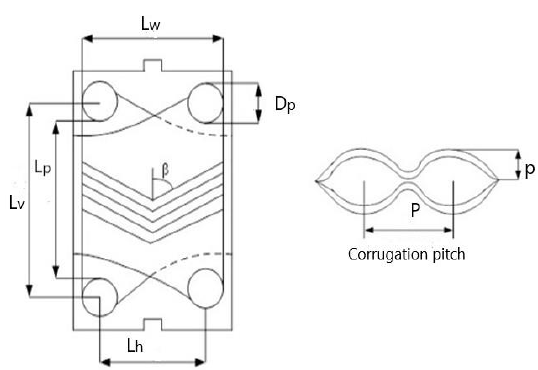
Figure 1. Main geometrical characteristics of a chevron corrugated